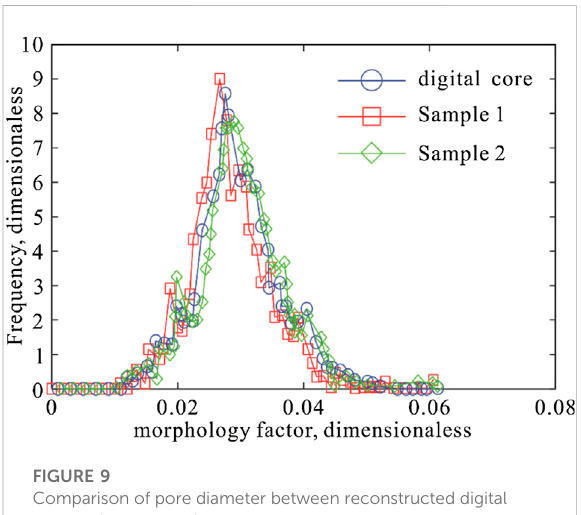
FIGURE 9 Comparison of pore diameter between reconstructed digital core and core